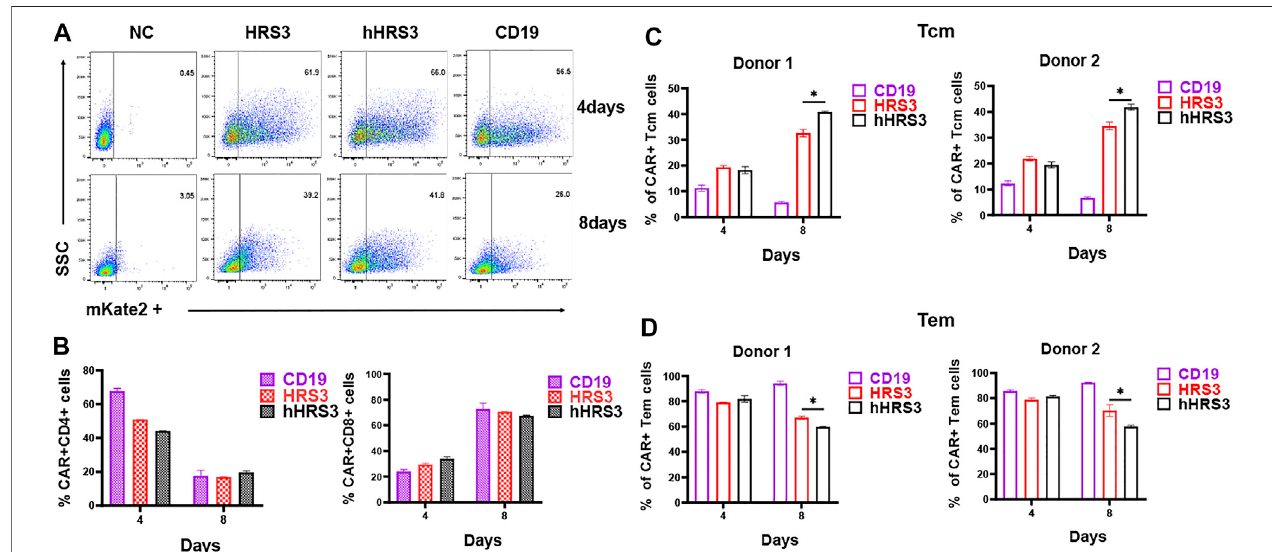
FIGURE3 | Detection ofCAR-T cell phenotypes. (A) Three days after culture initiation, the cells weretransduced with vectors encoding the indicated CARs, or the cellswereleftuntransduced.CellswerealsostainedwithProteinLtodetectCARs. (B) Fourand8 daysaftertransduction,thecellswerestainedwithantibodiesagainst CD4, and CD8. There were no signi fi cant differences between T cell expression for each CAR on day 4 and 8 post-infection. (C) T cell subpopulations were analysed in different CARs by fl ow cytometry (mean ± SD). T cells are functionally divided into four subsets: central memory (CCR7 + CD45RO + ) and effector memory (CCR7 − CD45RO + ), according to the cell surface expression of CCR7 and CD45RO. The in vitro experiments were independently repeated at least three times using different donor cell sources in fi gure A, B. The data in Figure (C,D) were from two independent experiments with three wells repeated per experiment. The results are presented as the mean volume ± SD, * p-value < 0.05 vs